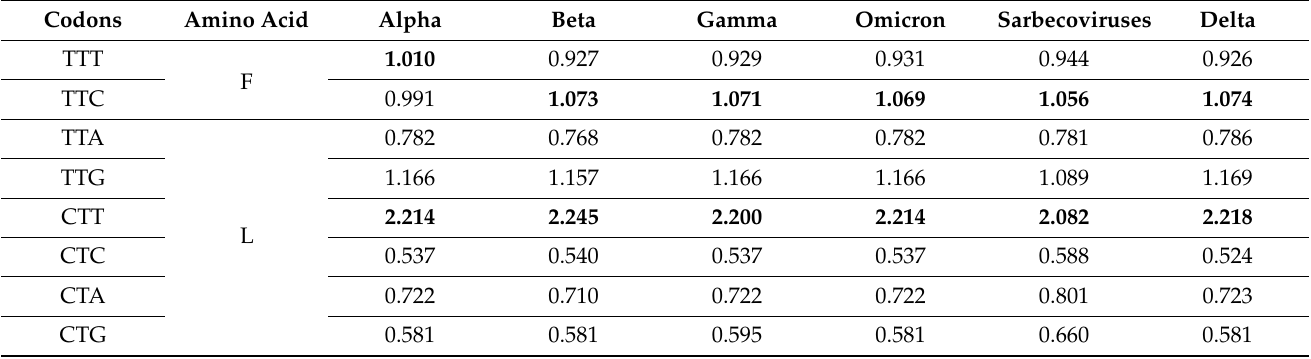
Table 3. Average RSCU values for representative SARS-CoV-2 VoCs and Sarbecoviruses. The most preferred codon for an amino acid from the synonymous codon family is given in